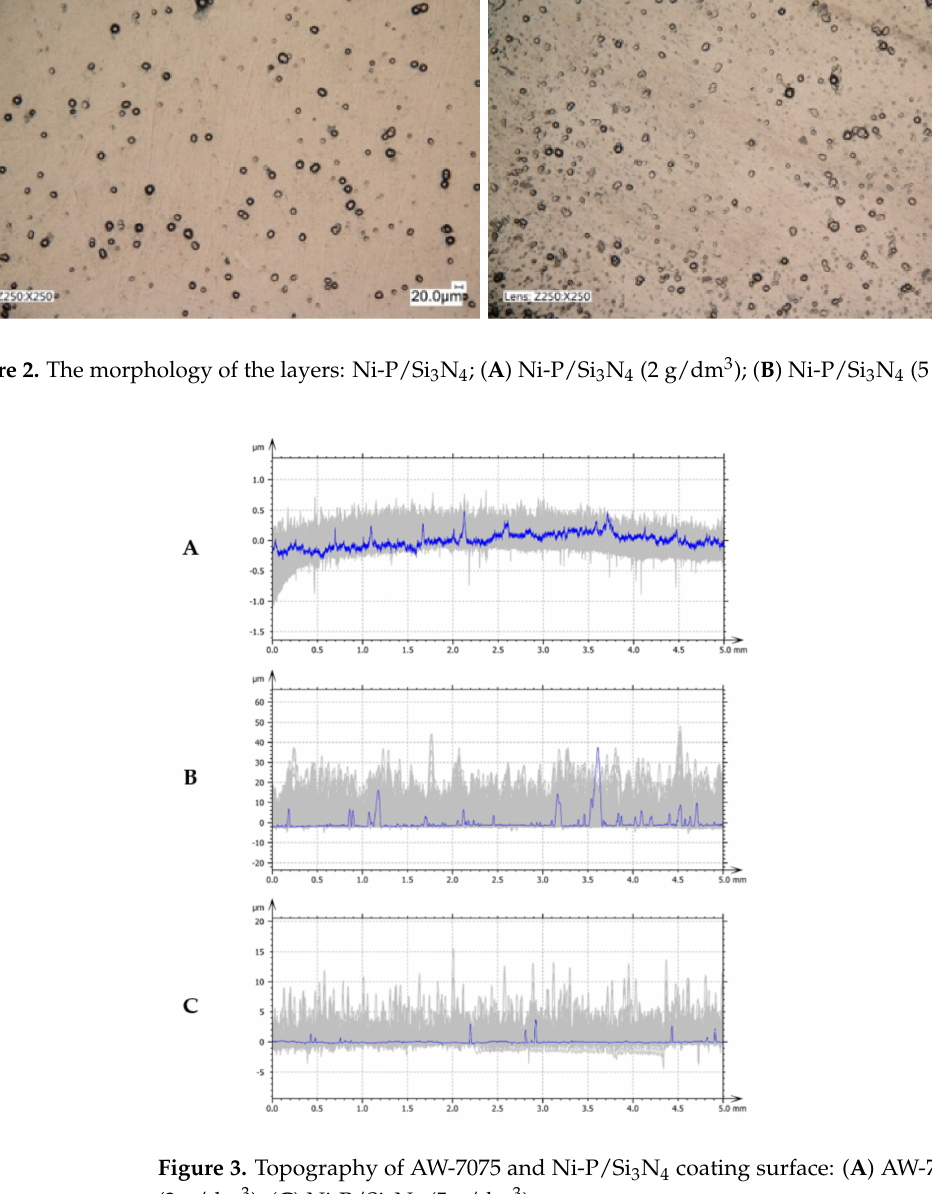
Figure 3. Topography of AW-7075 and Ni-P/Si 3 N 4 coating surface: ( A ) AW-7075; ( B ) Ni-P/Si 3 N 4 (2 g/dm 3 ); ( C ) Ni-P/Si 3 N 4 (5 g/dm 3